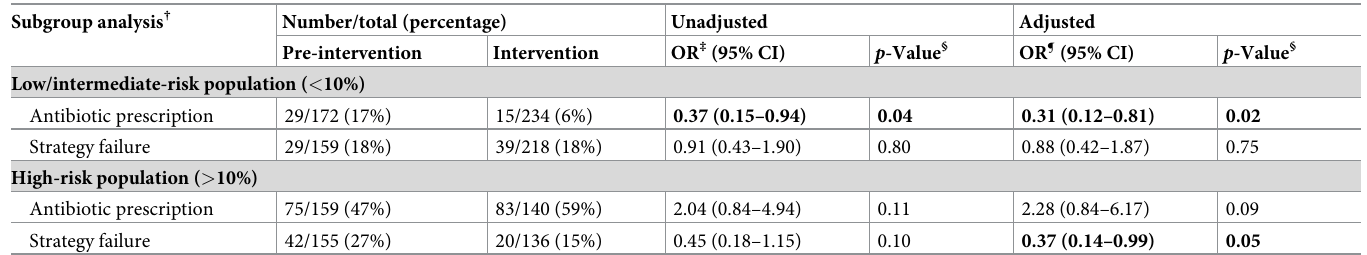
Bolding indicates statistical significance. � 331/597 (55%) cases were complete in the pre-intervention population, of which 172/331 (52%) were in the low or intermediate risk group ( n = 91 low risk; n = 81 intermediate risk); 374/402 (93%) cases were complete in the intervention population, of which 234/374 (63%) were in the low or intermediate risk group ( n = 115 low risk; n = 119 intermediate risk).